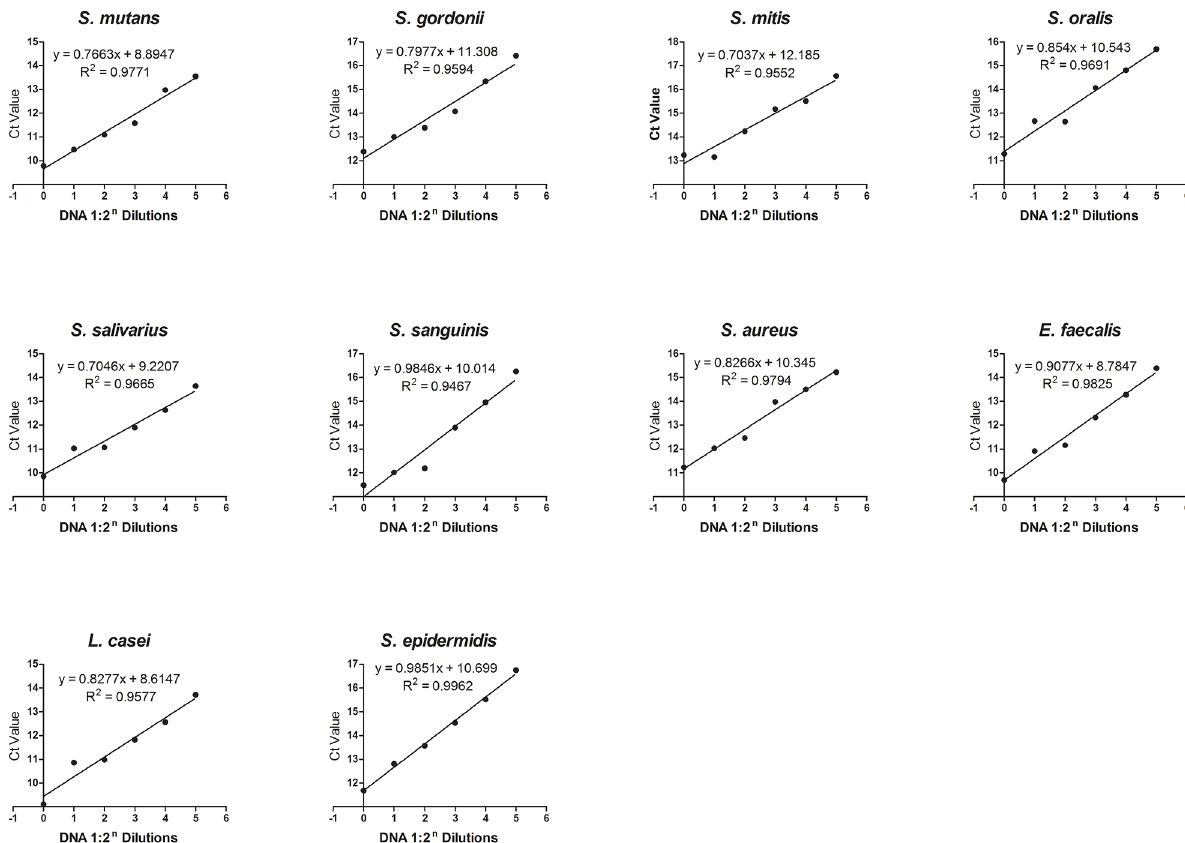
Fig 3. q-PCR efficiency test. The x-axis represents 1:2 n dilutions of DNA and the y-axis represents Ct values. Ideally, if one sample is diluted 1:2 ( Δ x = 1), it will take one more cycle ( Δ y = 1) to reach the same threshold. Ideally, the slope ( Δ y / Δ x ), which represents the amplification efficiency E , is equal to 1. For actual samples the slope is less than